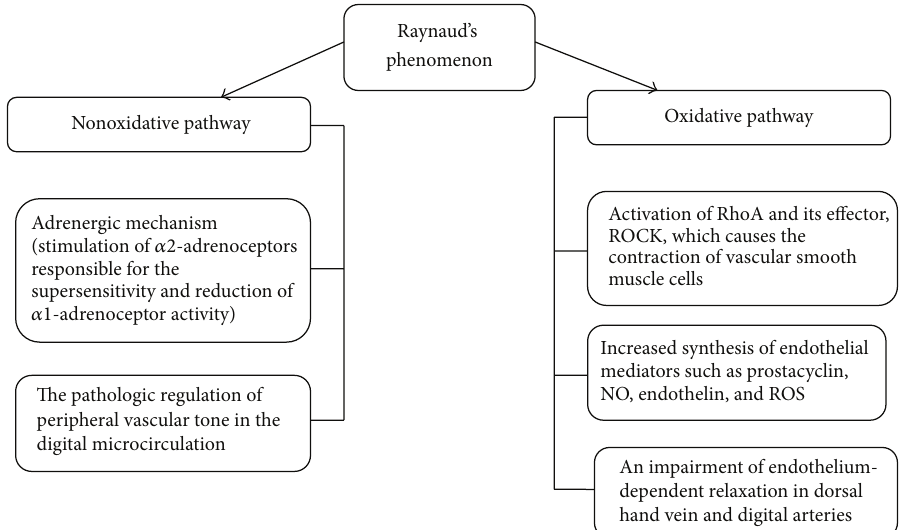
Figure 3: Background pathology of SSc-associated Raynaud’s phenomenon. RhoA: Ras homolog gene family, member A (a small GTPase protein regulating the actin cytoskeleton in the formation of stress fibers); ROCK: Rho kinase; NO: nitric oxide, ROS: reactive oxygen